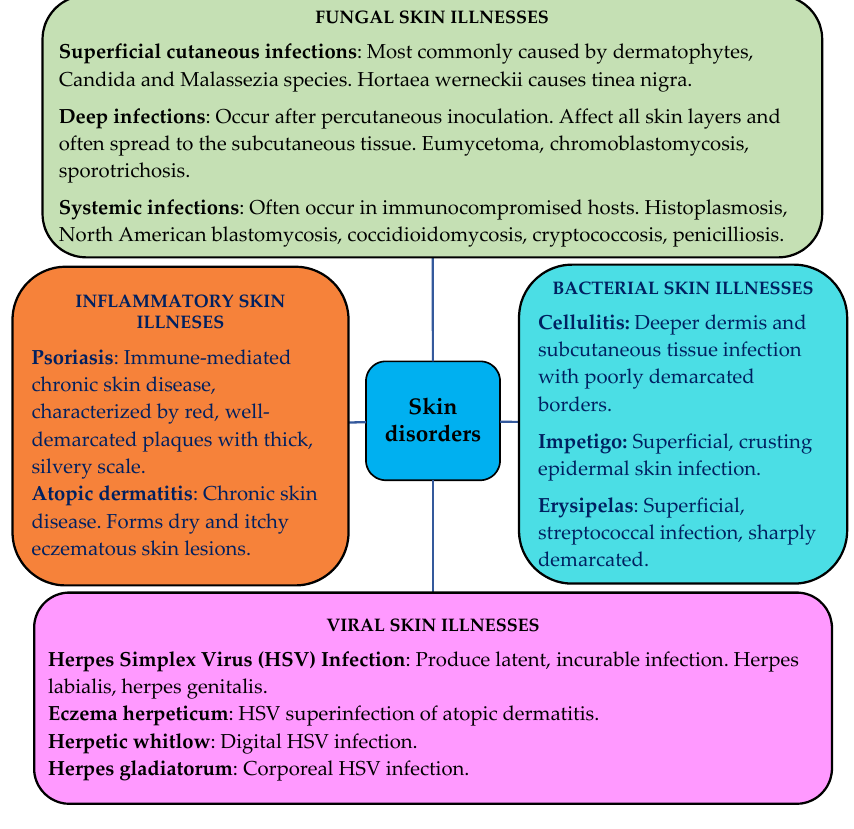
Figure 3. Representation of the most common skin disorders [32–43].